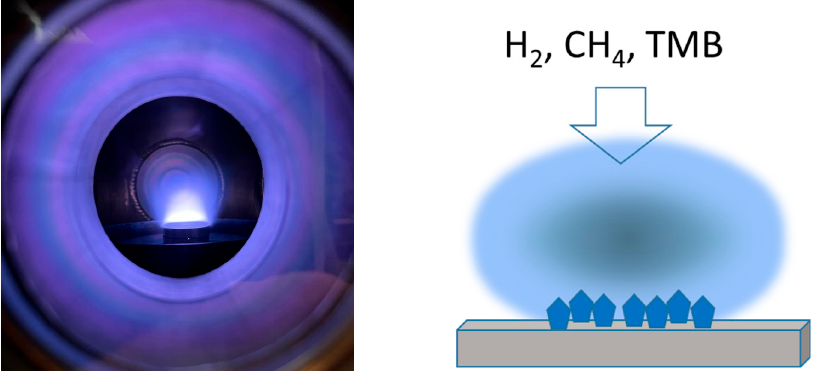
Figure A1. Plasma CVD deposition of diamond films ( left ) from the seeded substrates is shown schematically ( right ).